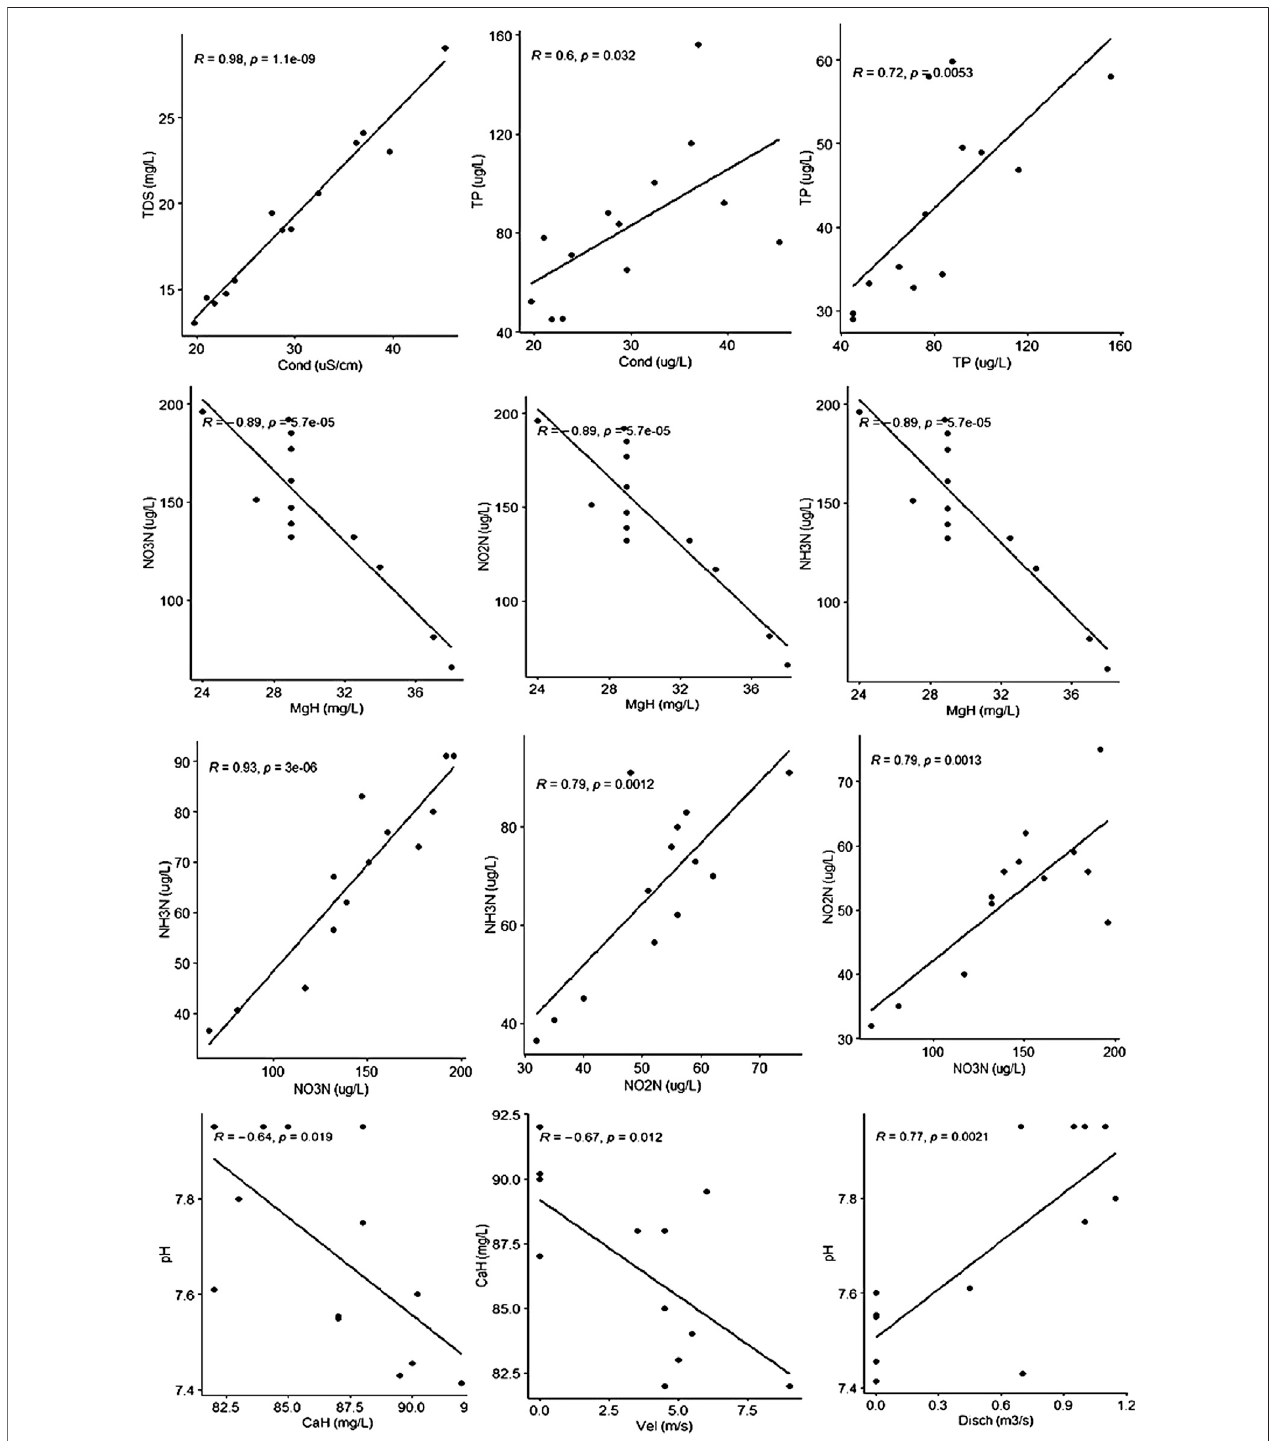
FIGURE 7 | Correlation plots of various physicochemical parameters of water samples from the investigated sites ( p ˂ 0.05).